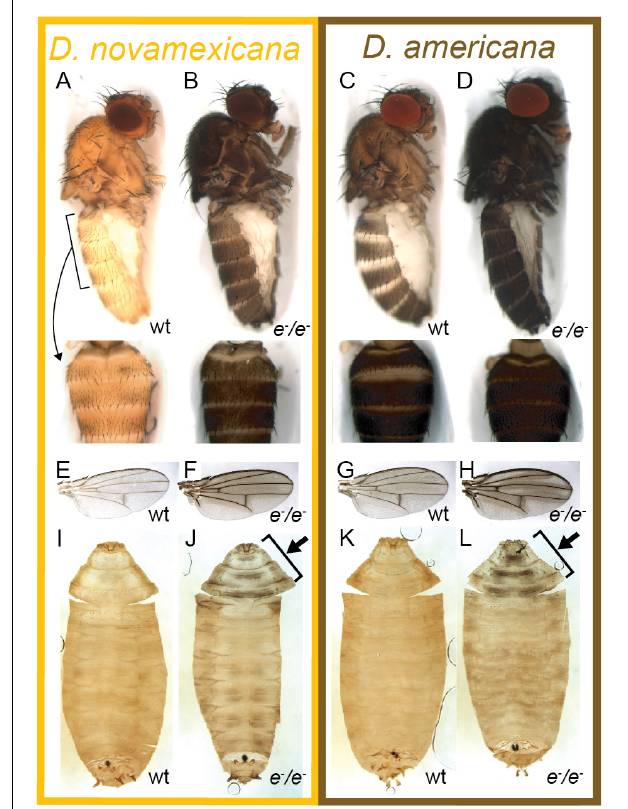
FIGURE 2 | Ebony affects body, wing, and pupal pigmentation in D. novamexicana and D. americana . (A–D) Adult body pigmentation is shown from a lateral view (top) and dorsal abdominal view (segments A2–A4, bottom) for (A) D. novamexicana , (B) D. novamexicana ebony null mutants, (C) D. americana , and (D) D. americana ebony null mutants. (E–H) Adult wing pigmentation is shown for (E) D. novamexicana , (F) D. novamexicana ebony null mutants, (G) D. americana , and (H) D. americana ebony null mutants. (I–L) Pigmentation of pupal cases is shown for (I) D. novamexicana , (J) D. novamexicana ebony null mutants, (K) D. americana , and (L) D. americana ebony null mutants. Arrows in (J,L) highlight the most prominent areas with dark pigmentation in ebony